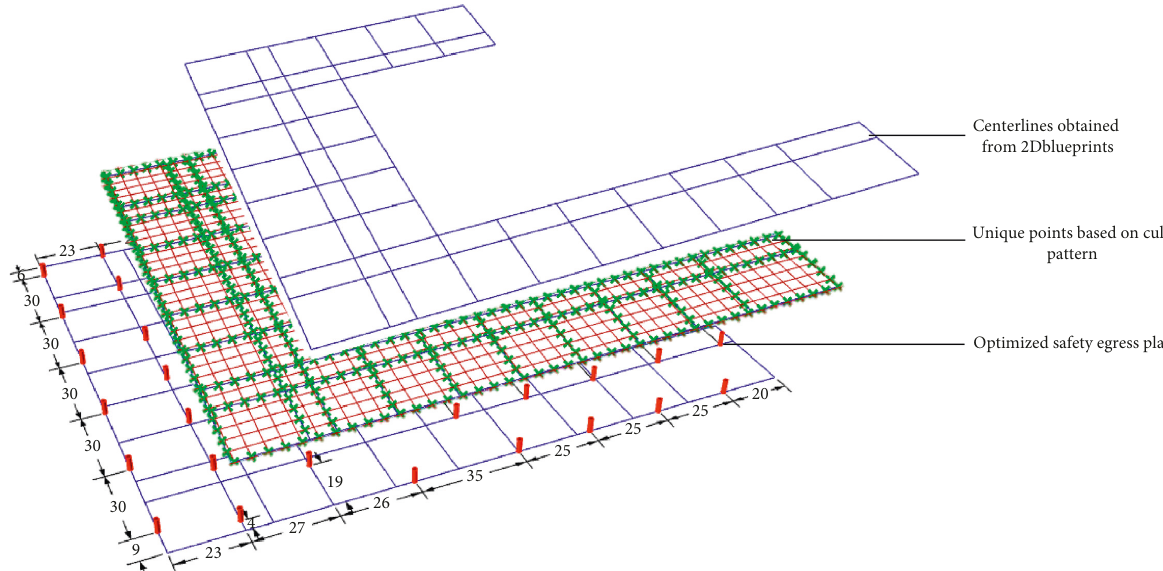
Figure 11: Automated excavation safety planning